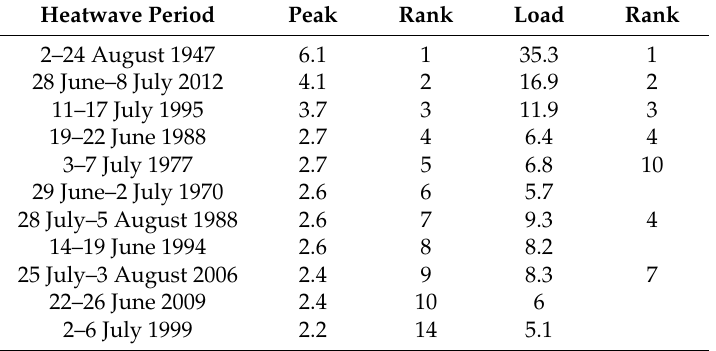
Table 6. Heatwave event peak and load using severity for Chicago (O’Hare Airport, 1946 to 2018). Top 10 ranked for event peak severity. Rank 14 inserted. Severity is dimensionless [].